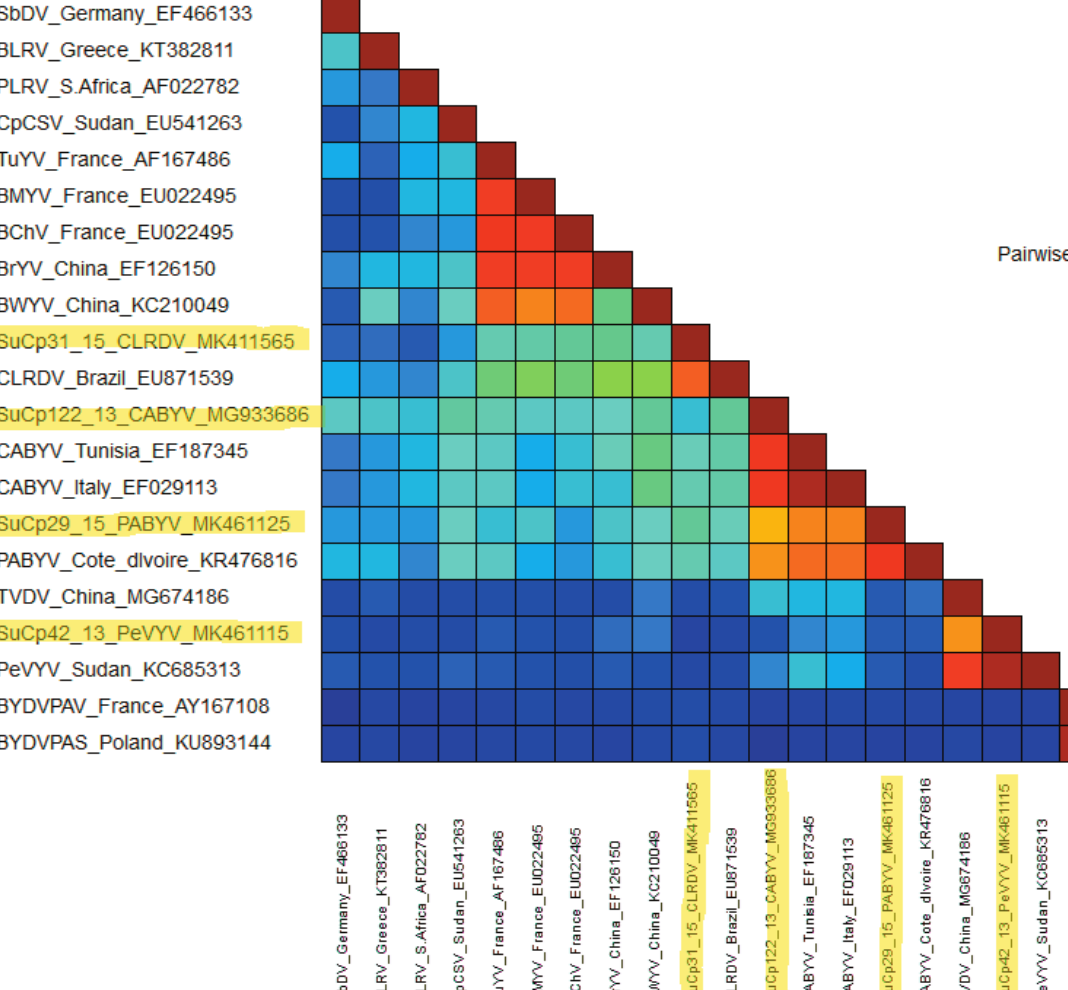
Figure 4. Two dimensional percentage pair wise similarity plot matrix of different selected strains of Luteoviridae generated using the Spe- cies Demarcation Tool (http://web.cbio.uct.ac.za/SDT). Each coloured cell represents a percentage similarity between two sequences (one indicated horizontally to the left and the other vertically at the bottom) displayed in the colour key. The luteovirid isolates from Sudan are highlighted, and all accessions details used for this study are listed in Table